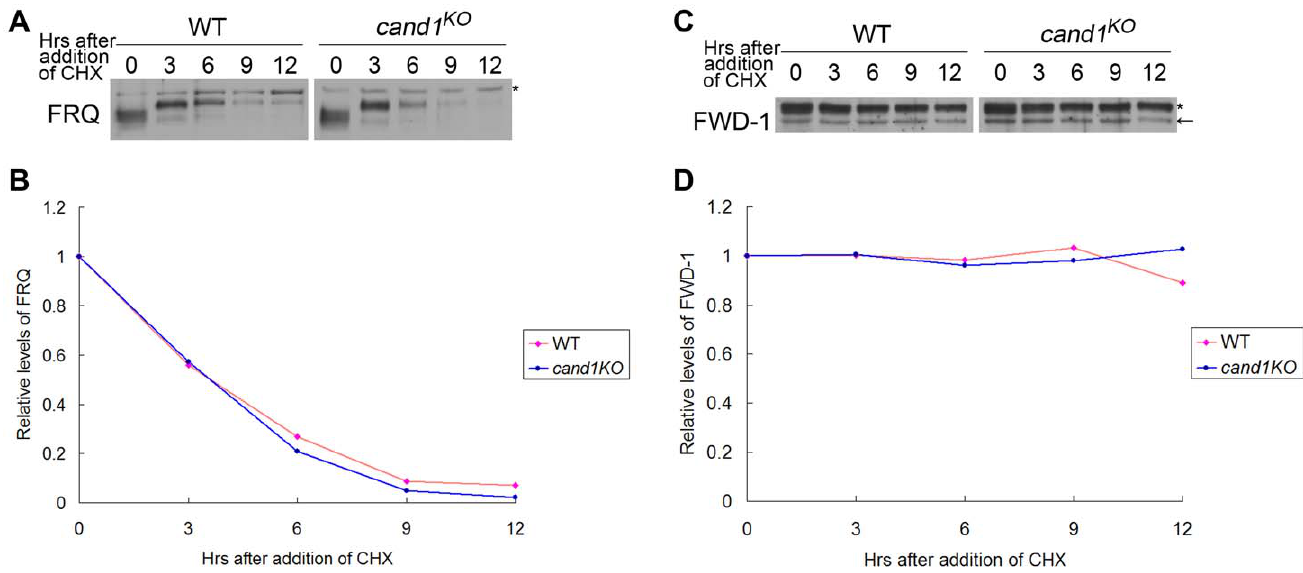
Figure 8. CAND1 is not required for regulation of the SCF FWD-1 ubiquitin ligase. Western blot analyses showing degradation of FRQ (A) and FWD-1 (C) in wild-type and cand1 KO strains after addition of cycloheximide (10 mg/mL). Densitometric analyses from four independent experiments showing the degradation of FRQ (B) and FWD-1 (D). Arrows point out FWD-1 protein bands. Asterisks indicate nonspecific bands detected by FRQ antibody (A) or FWD-1 antibody